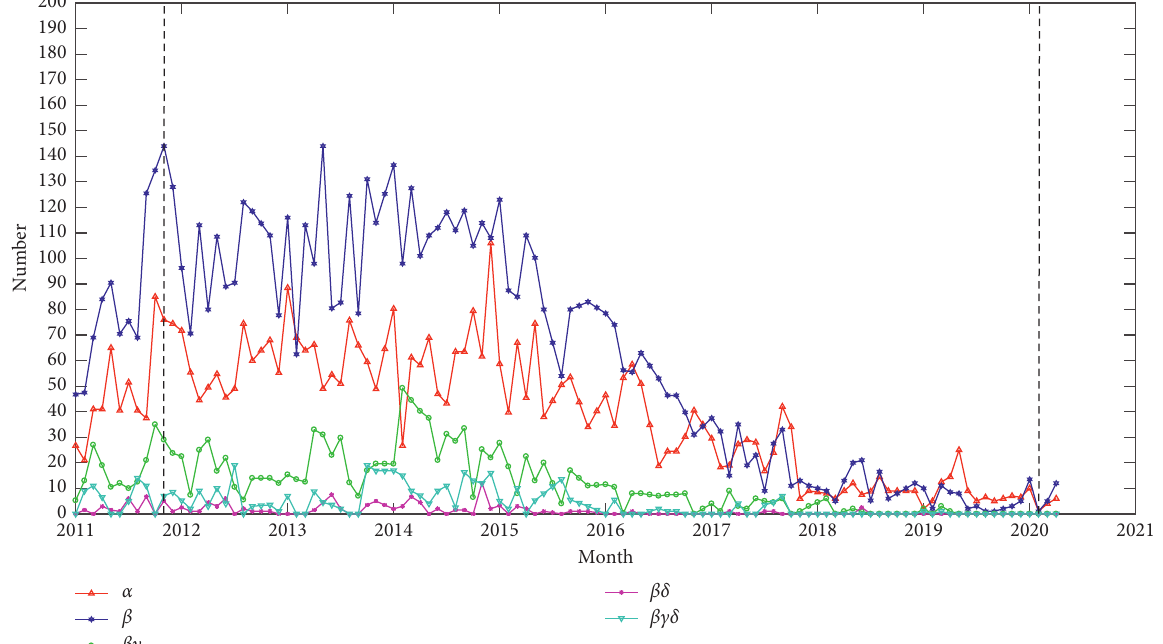
Figure 5: The total number for each type of sunspot groups in months from January 2011 to April 2020. The left dashed vertical line (November 2011) represents that the numbers of various types differ significantly, where the maximum difference is up to 139. The right dashed vertical line (February 2020) represents the numbers of various types that are very close, where the maximum difference is only 1. Table 3: The number of various types of the sunspot groups and the corresponding flare productivity from 2011 to 2020 ( I Type